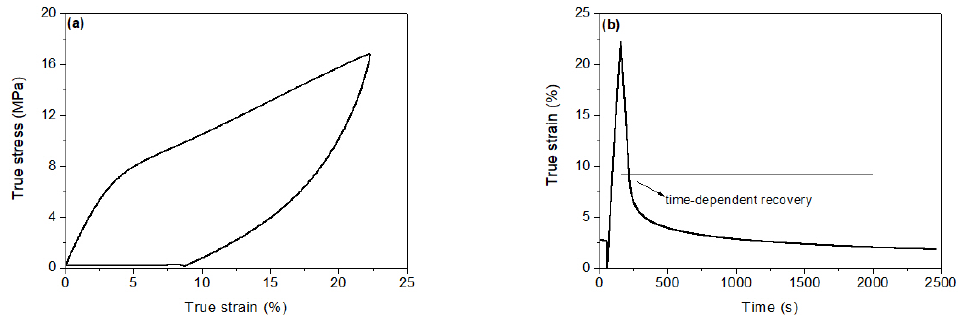
Figure 4. ( a ) Relationship between true stress and true strain and ( b ) Observed dependency of the strain recovery on time.